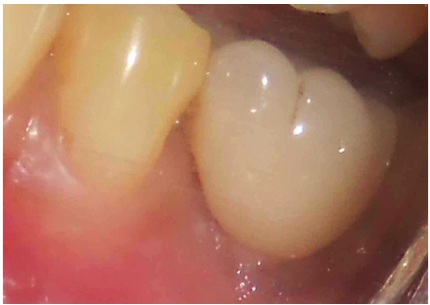
Figure 7: IOPA of implant-abutment assembly.